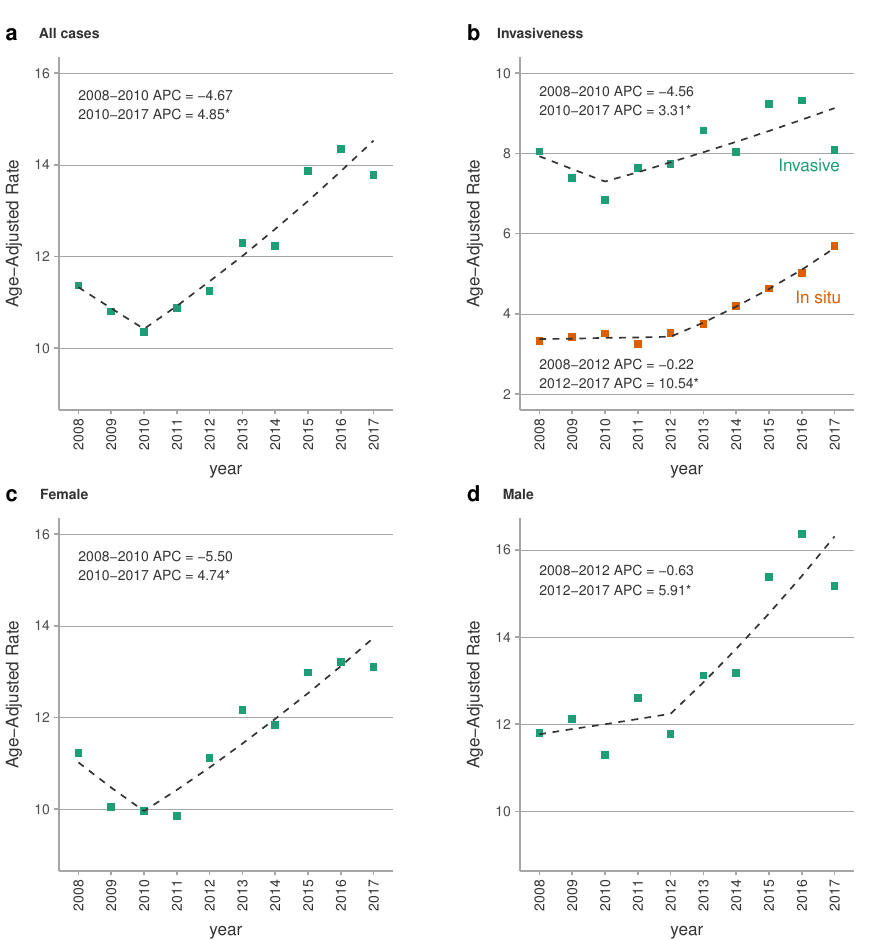
Figure 3. Joinpoint regression analysis of melanoma age-standardised incidence rate. European age-standardised incidence rate trends for melanoma lesions in Catalonia in the period 2008–2017. Squares shapes represent the observed values and dashed lines represent the joinpoint models. (*) APCs were significantly different from zero at alpha = 0.05. Abbreviations: APC, annual percent